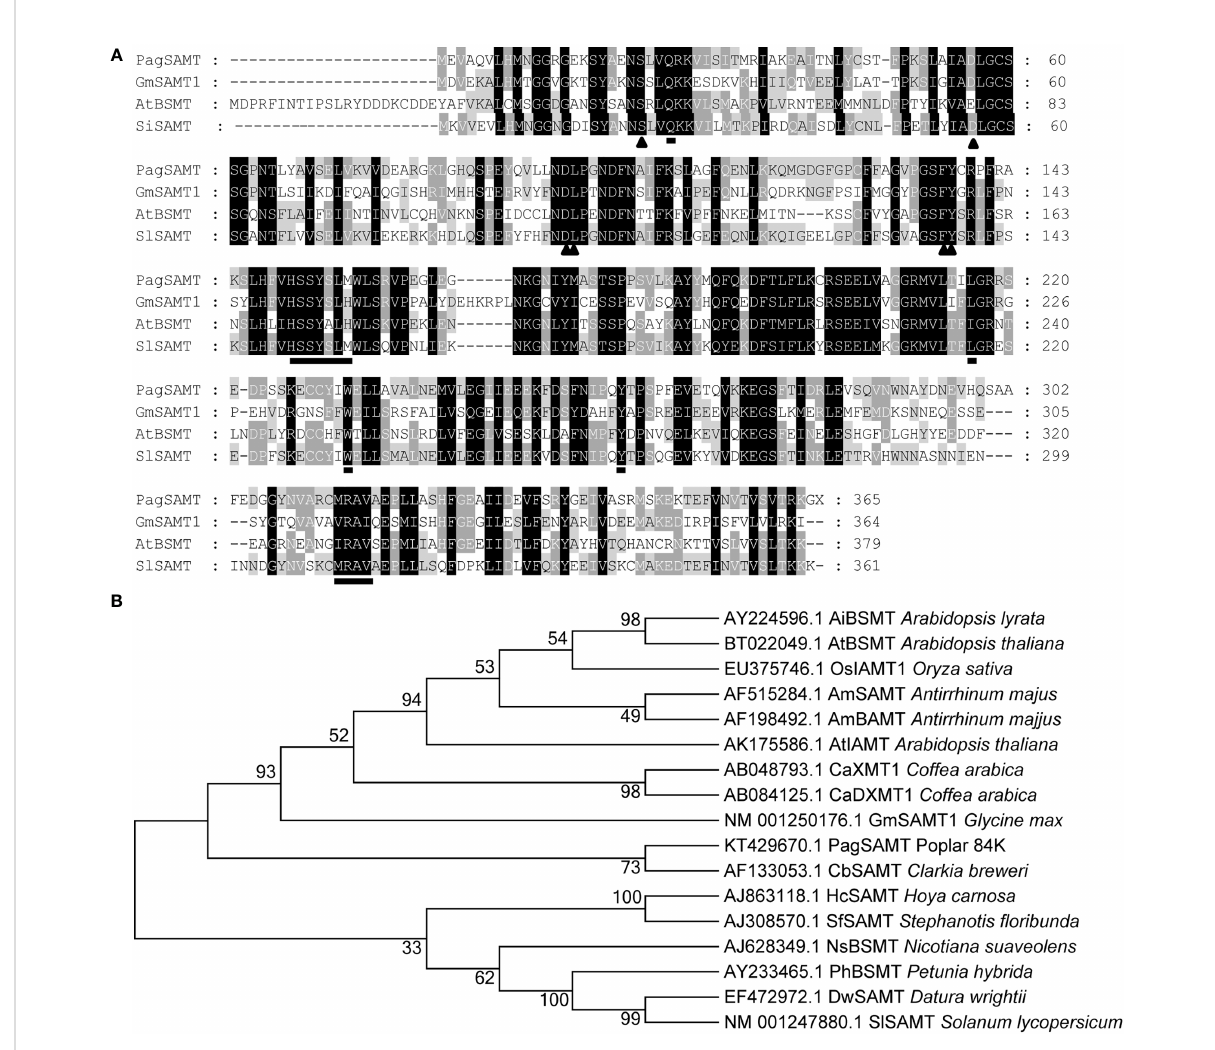
FIGURE 1 Sequence alignment of PagSAMT with other plant methyltransferases. (A) Multiple sequence alignment of PagSAMT with selected known SAMTs. The triangles indicate S-adenosyl-L-methionine (SAM) binding residue. The underlined amino acids represent SA binding residues. GmSAMT1, Glycine max SAMT1 (NM_001250176.1); AtBSMT, Arabidopsis thaliana BSMT (BT022049.1); SISAMT, Solanum lycopersicum SAMT (NM_001247880.1). (B) Phylogenetic tree containing PagSAMT and other members of the plant SABATH family of methyltransferases. The numbers at nodes in the phylogenetic tree represent the bootstrap values for 1000